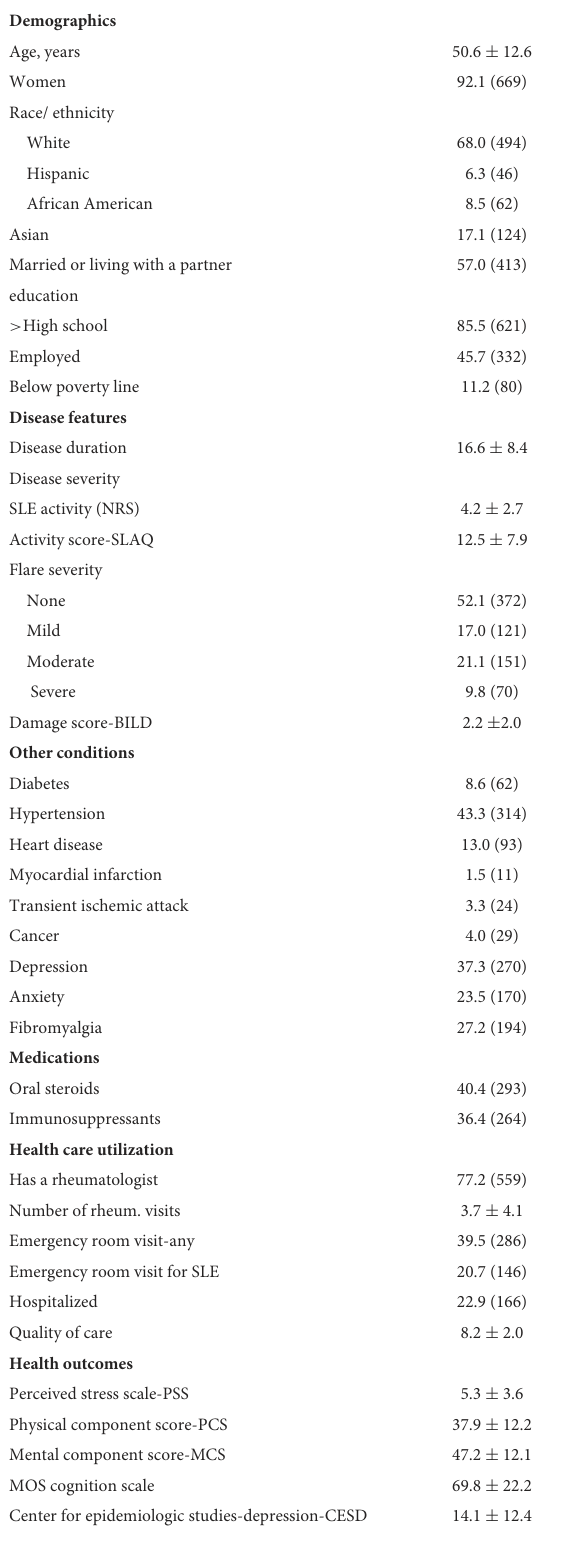
TABLE 1 Description of the SLE cohort at